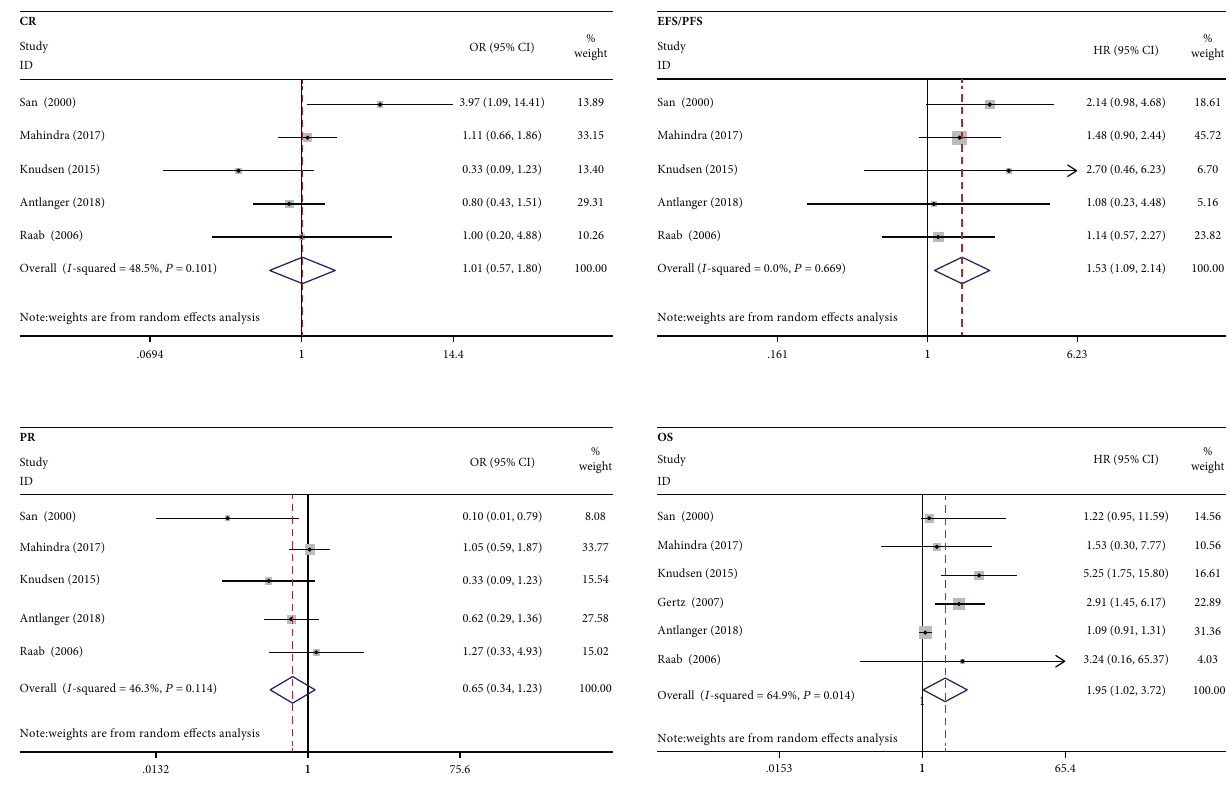
Figure 2: ASCT in myeloma patients with renal failure, survival analysis, and clinical